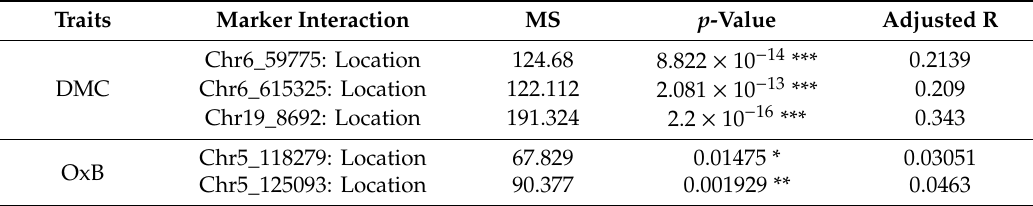
Table 4. Markers associated with the tuber DMC and OxB with their variation across locations. Traits